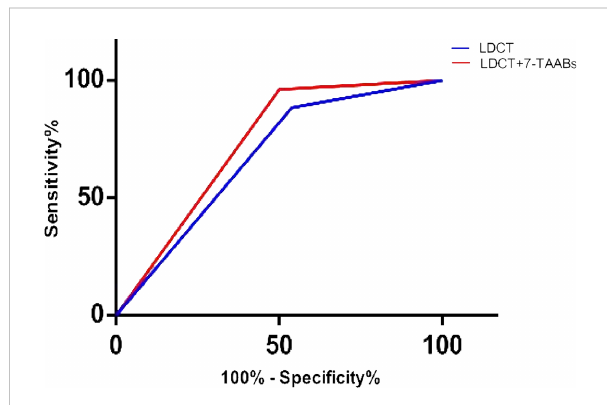
FIGURE 2 AUCs for LDCT and the combined detection in patients versus healthy